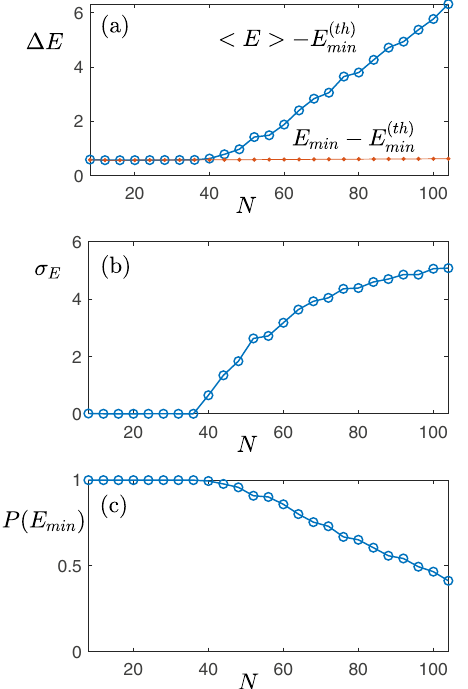
Fig. 10 Scaling to larger network sizes. a Dependence of the deviation Δ E of the fi nal mean energy < E > (averaged over 1000 realizations) from the theoretical ground state energy E ð th Þ min as a function of N for Möbius-ladder networks. The red line marks the difference between the minimum energy E min reached in simulations and the theoretical one. b Standard deviation, σ E , of the fi nal network energy after 1000 realizations as a function of the network size N . c Probability to reach the ground state network energy E min in 1000 realizations for increasing network size N